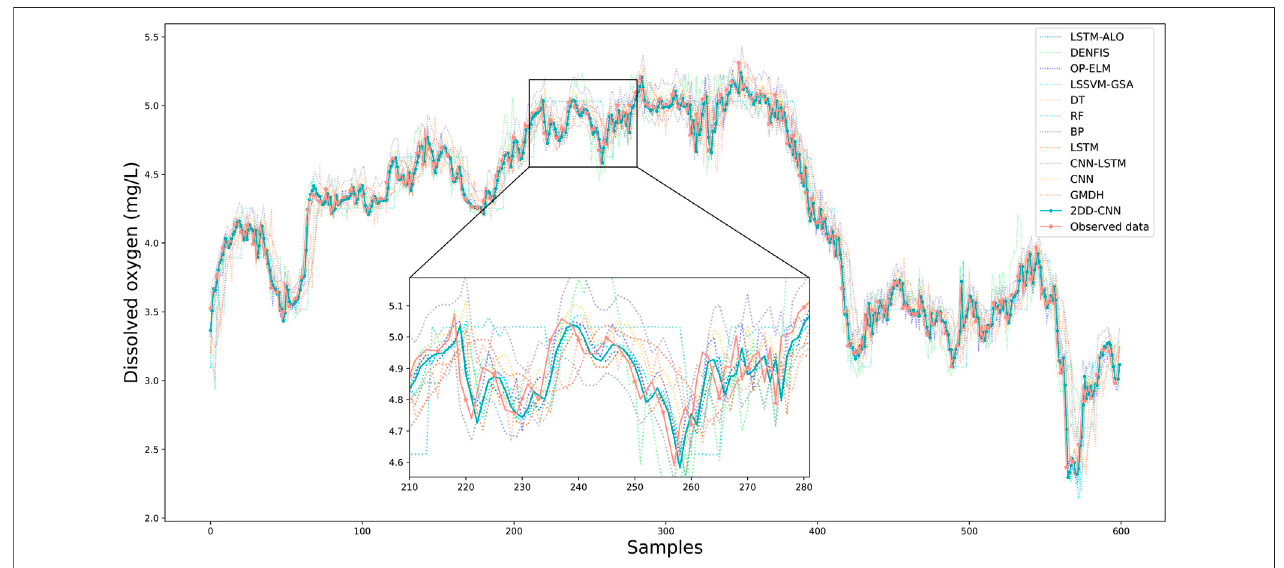
FIGURE 6 | The DO content prediction results.